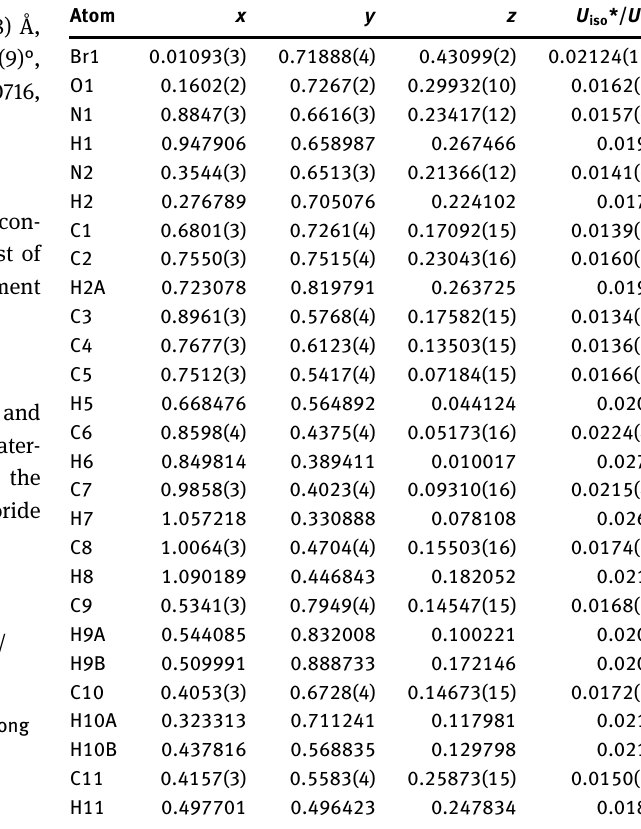
Table 2: Fractional atomic coordinates and isotropic or equivalent isotropic displacement parameters (Å 2